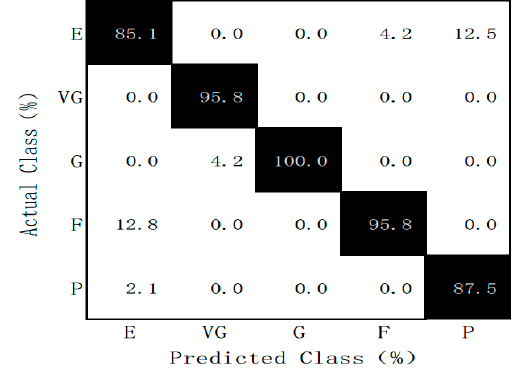
Figure 3. Confusion matrix of the lute classification of 5